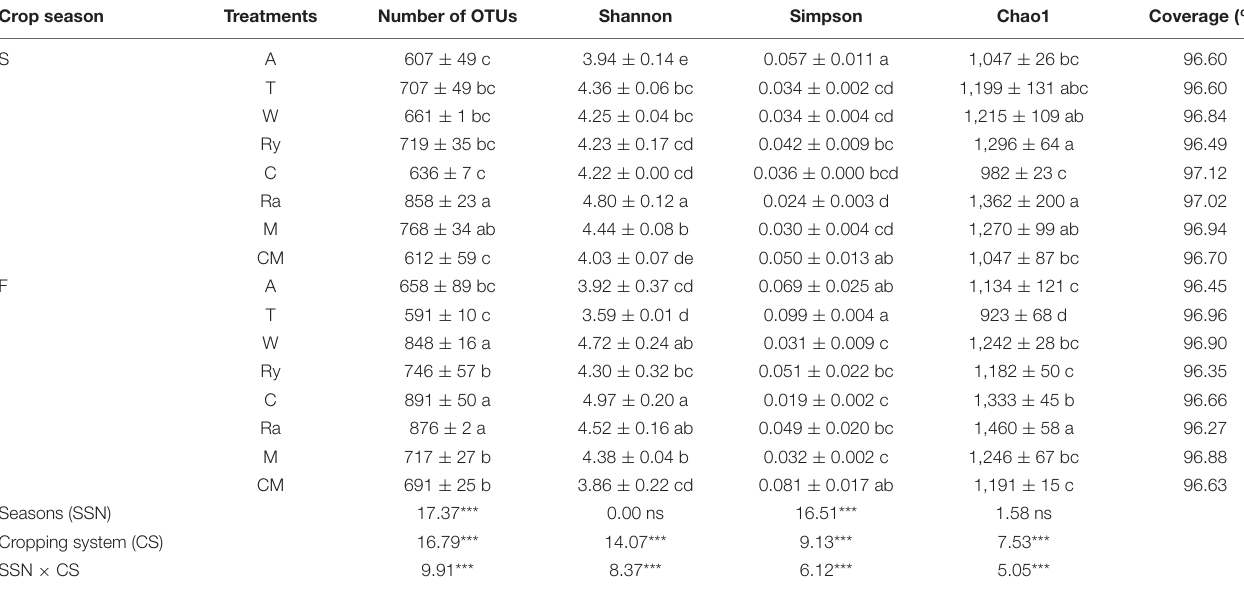
TABLE 2 | Number of OTUs and diversity indices of the diazotrophic communities in the soils of cucumber crops for all treatments.